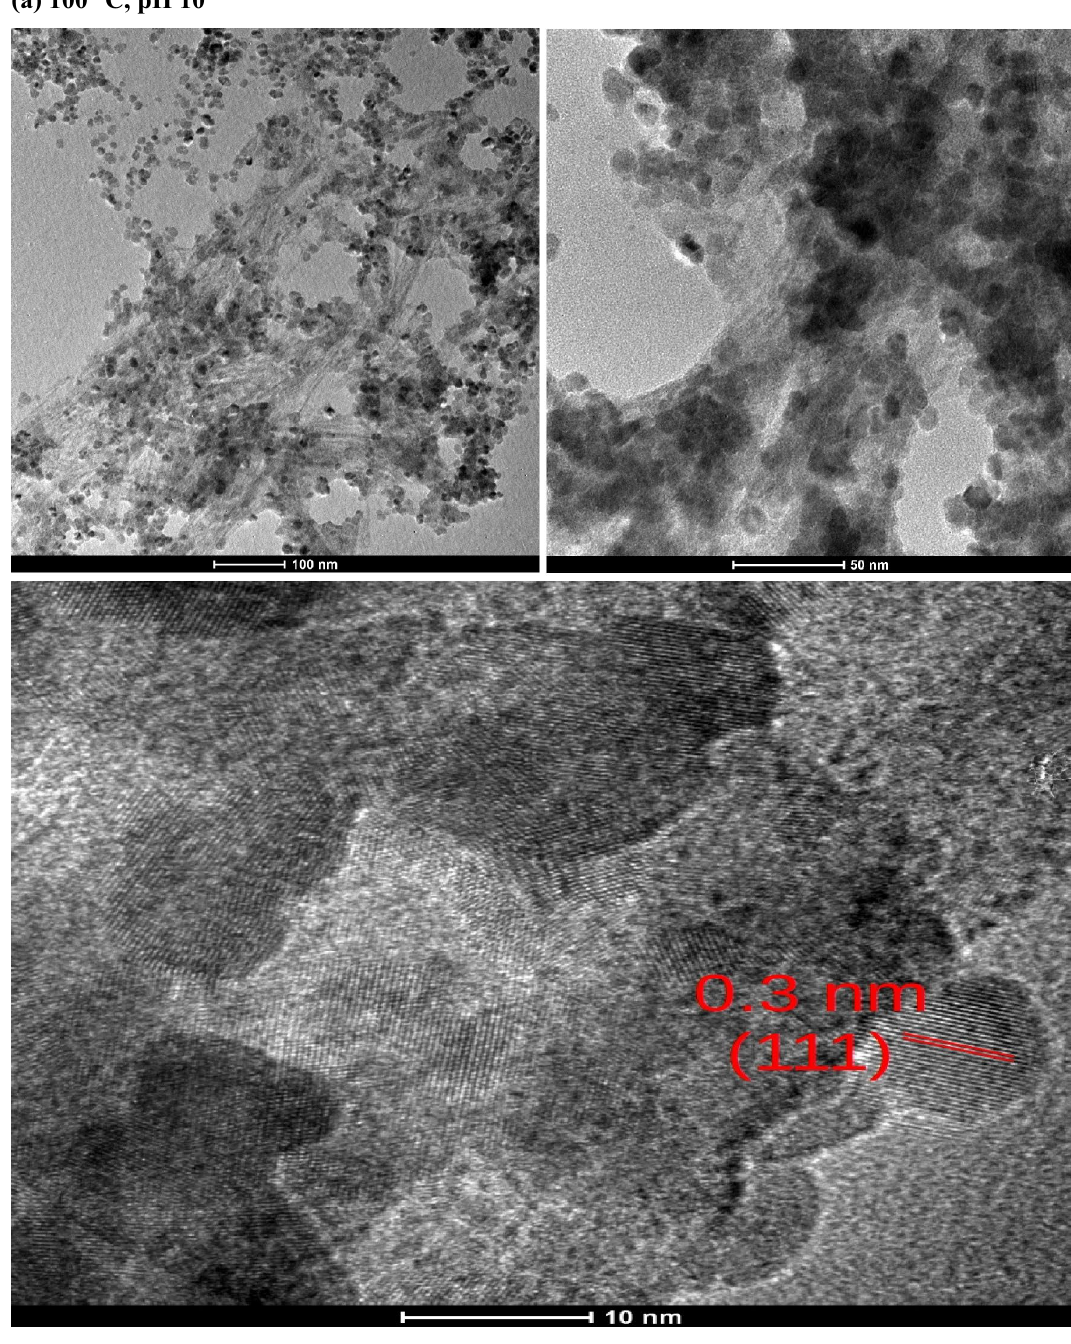
Figure 3. TEM micrographs of samples prepared at 100 °C and 120 °C with pH 10 and 14,